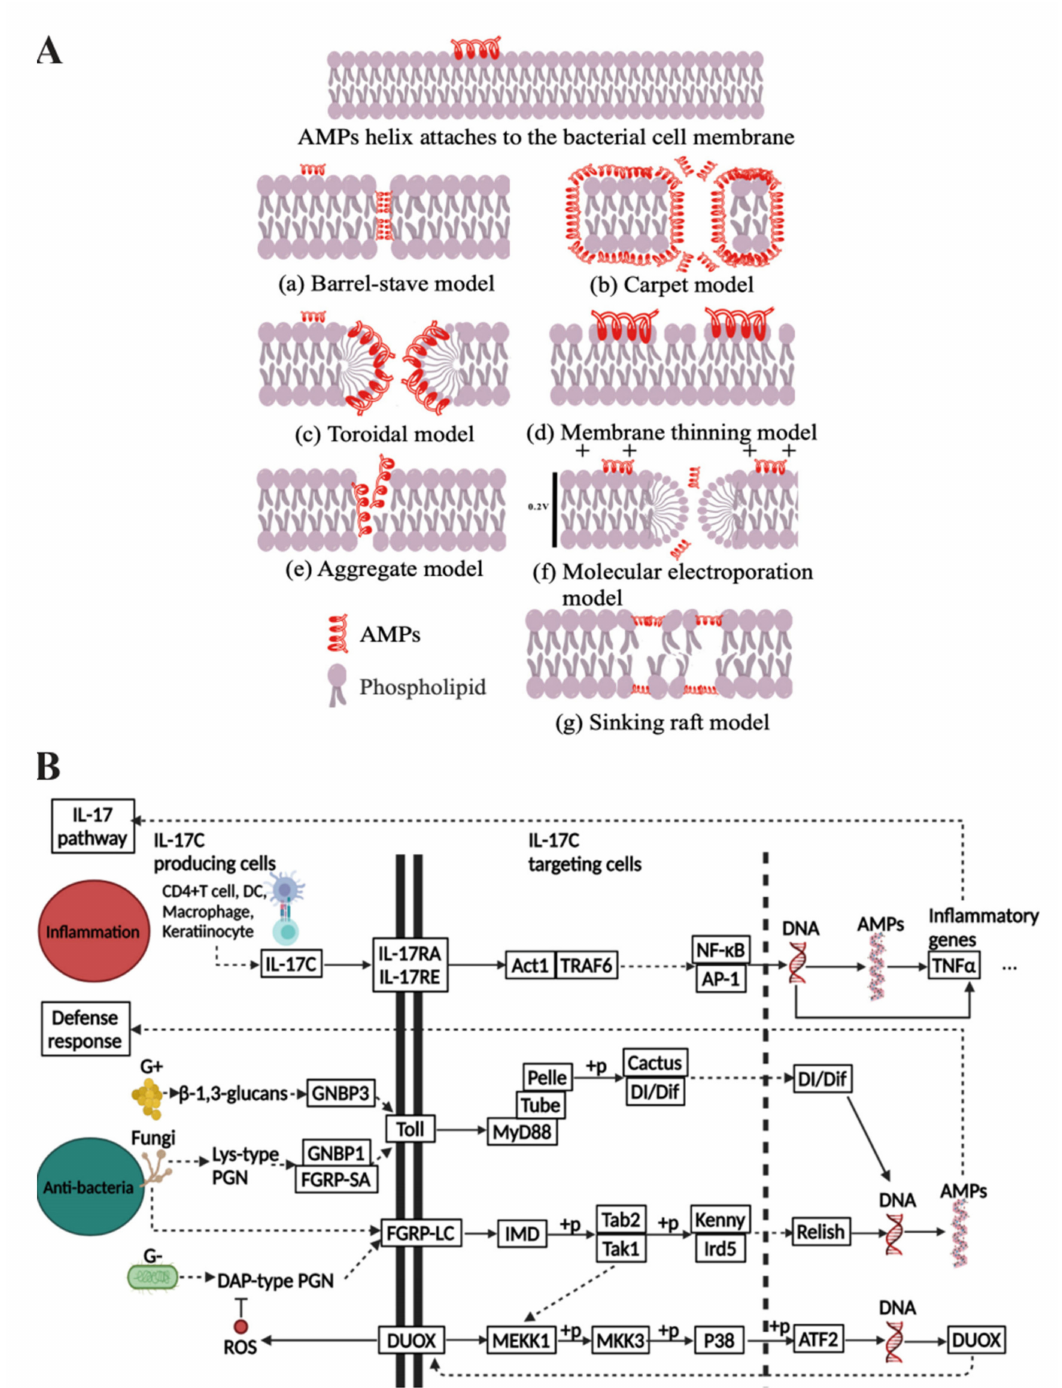
Figure 1. ( A ) Membrane lysis antibacterial mechanisms of AMPs (AMPs in red). ( B ) Putative models of inflammation and antibacterial pathways of AMPs by making use of pathway data from KEGG database